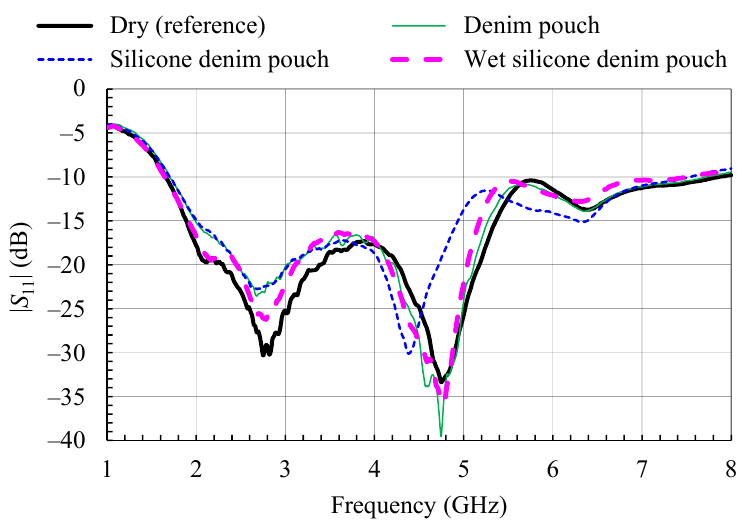
Figure 14. Measured magnitude of the input reflection coefficient of the wideband textile monopole with protective silicone-sealant-coated denim pouch.